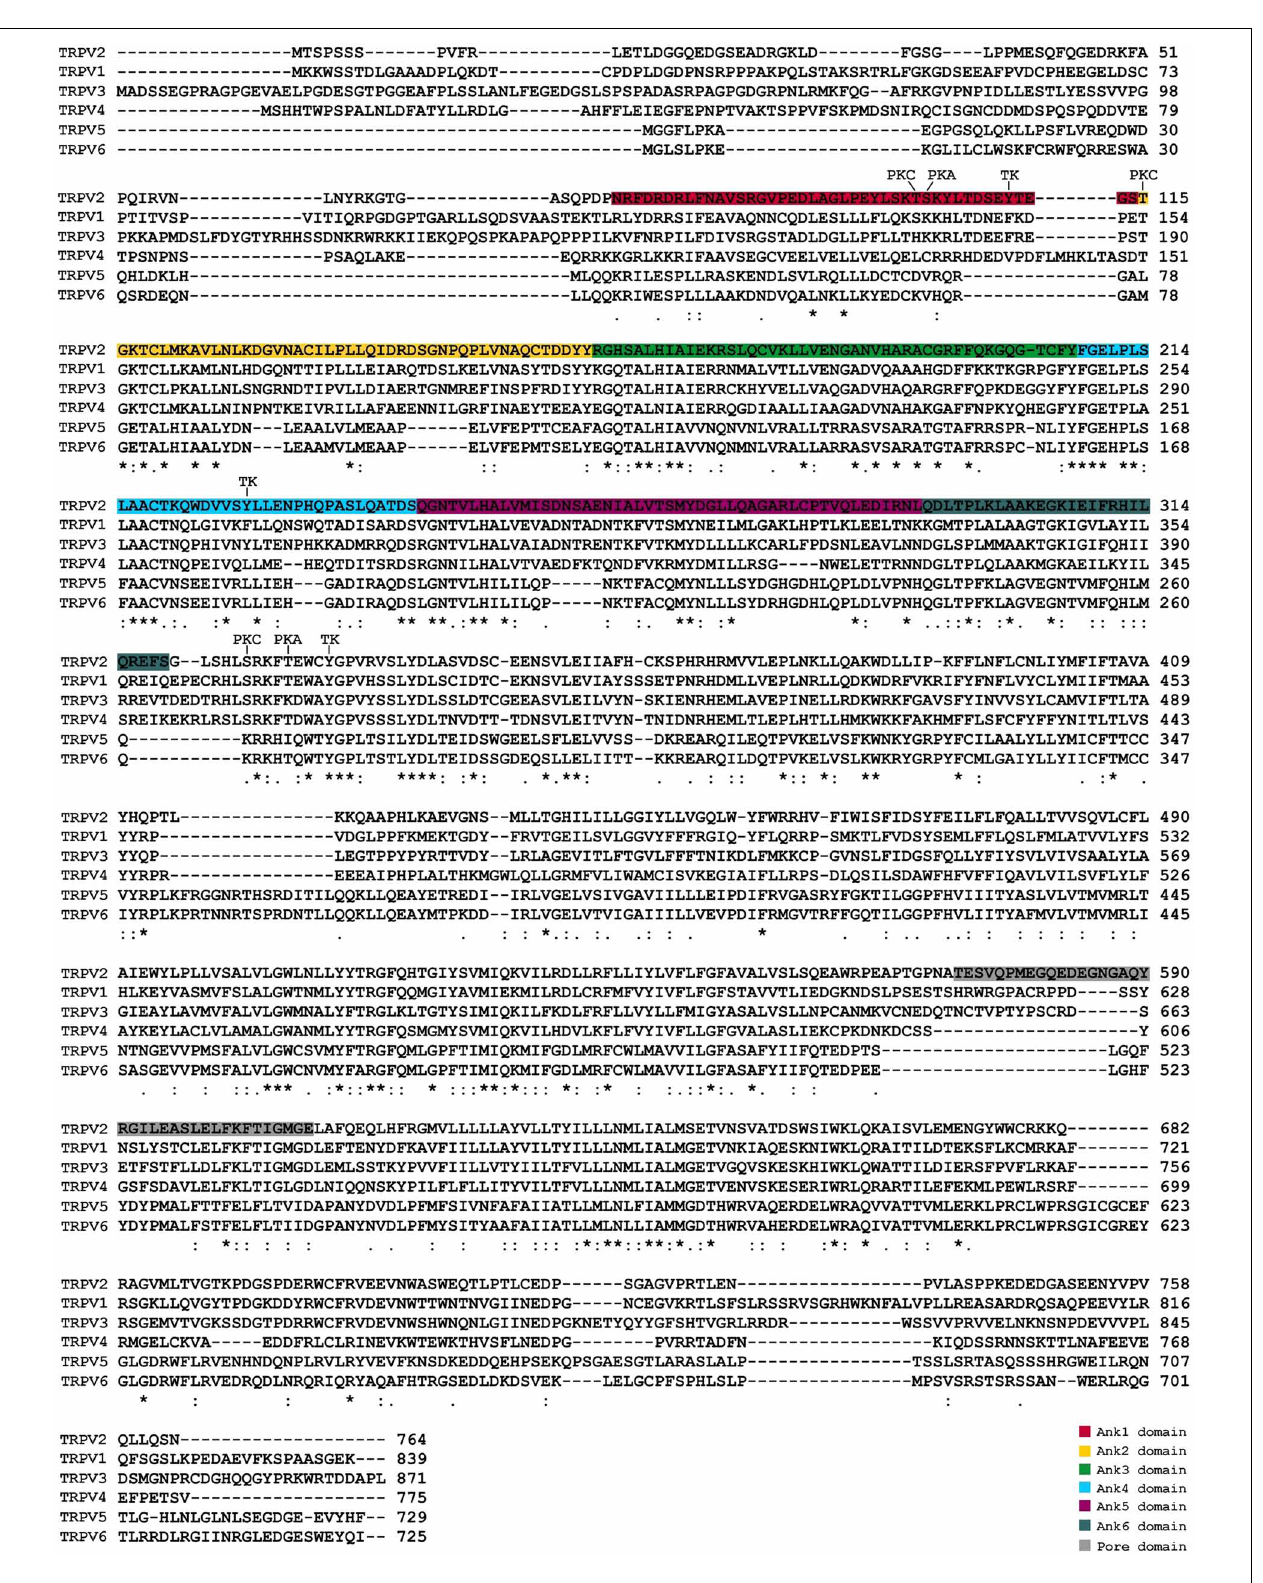
FIGURE 1 |Alignment and comparison of humanTRPVs amino acid structure, highlighting the known functional domains and the potential phosphorylation sites. PKA, protein kinase A; PKC, protein kinase C;TK, tyrosine kinase.